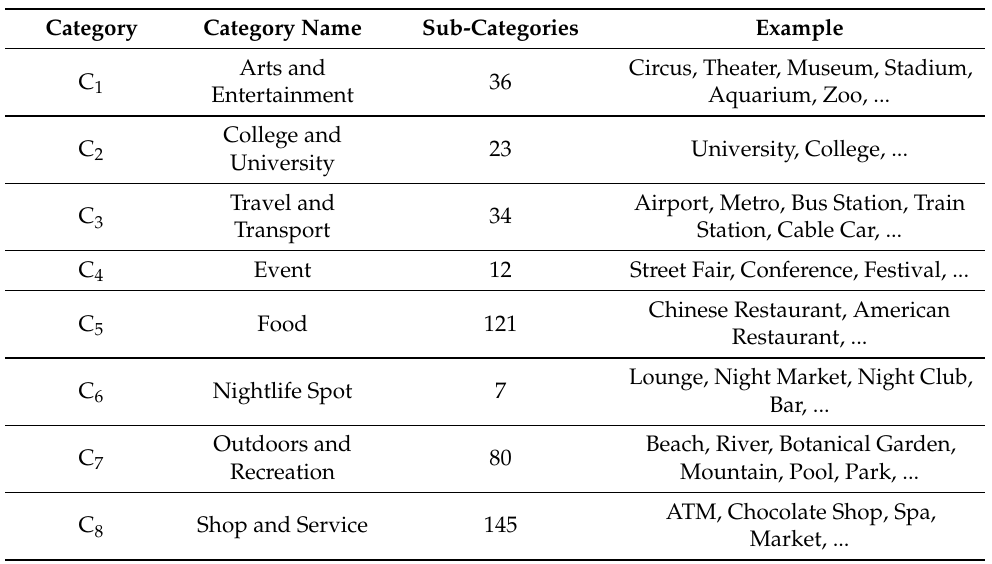
Table 7. Location categories in